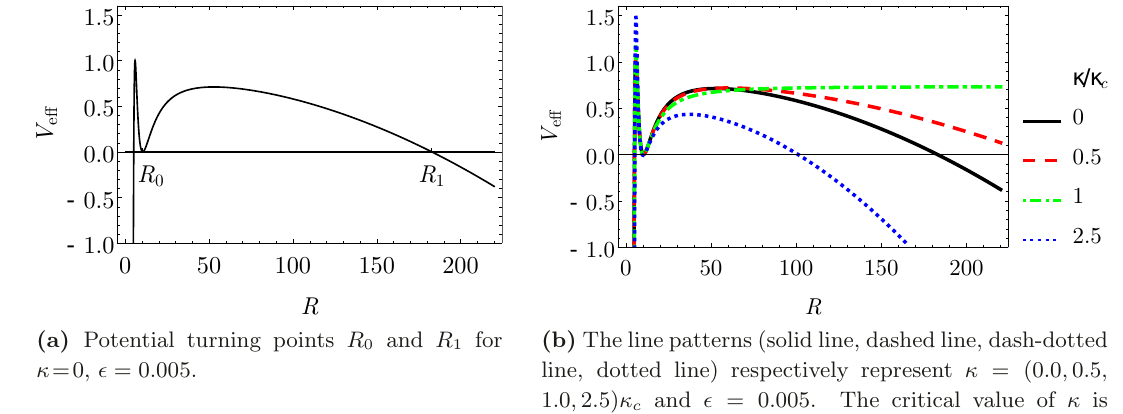
(b) The line patterns (solid line, dashed line, dash-dotted line, dotted line) respectively represent κ = (0 . 0 , 0 . 5 , 1 . 0 , 2 . 5) κ c and ǫ = 0 . 005. The critical value of κ is κ c ≡ ǫ/σ 2 .